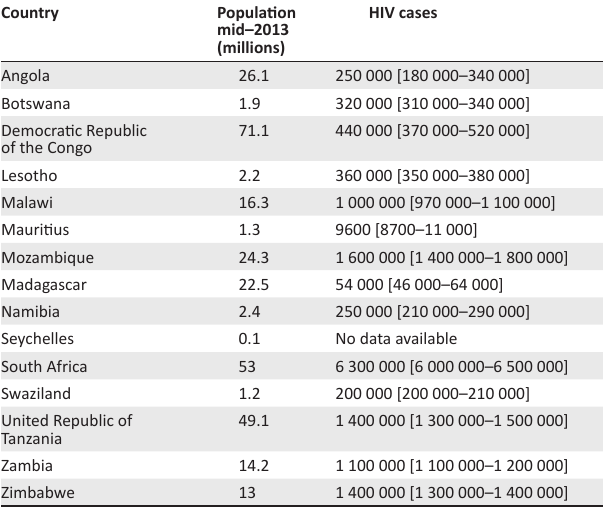
TABLE 1: Estimates of HIV cases 2013 (Southern African Development Community region).